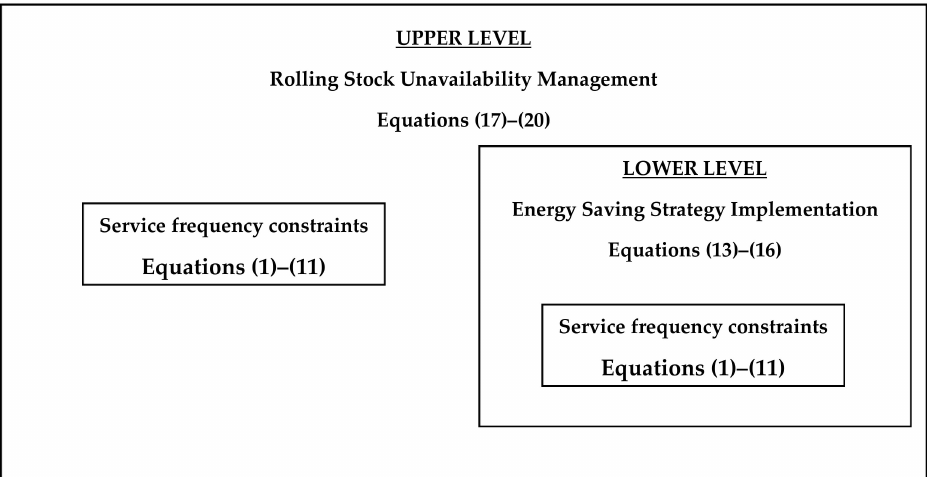
Figure 5. Framework of the proposed bilevel optimisation